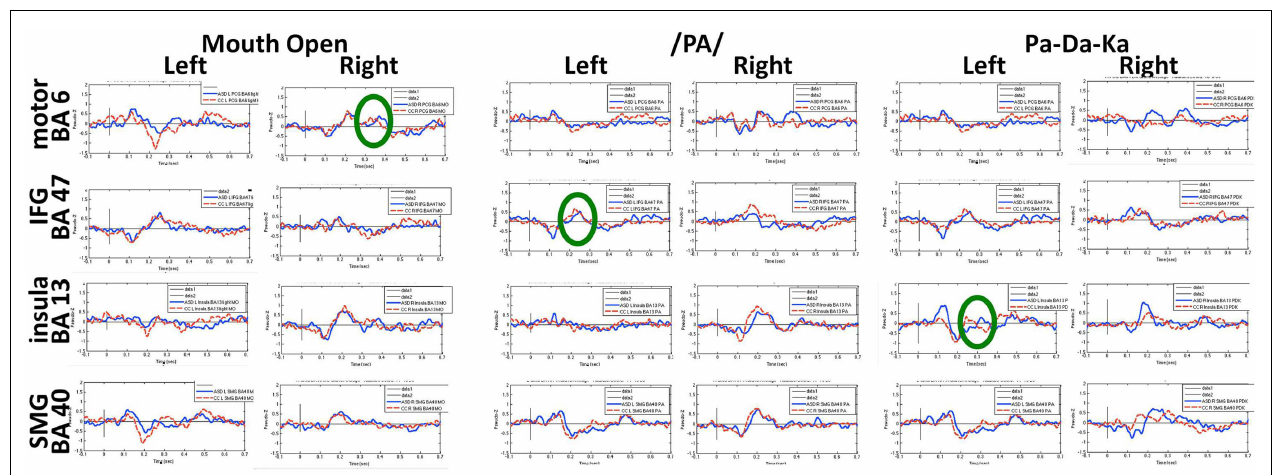
FIGURE 6 |Time courses of activations used in magnitude analyses for each speech production condition. Circles indicate neural locations where statistically significant differences were seen in the peak magnitude between children with autism (blue line) and control children (red line).These data for Figures 6 and 7 were analyzed with synthetic aperture magnetometry beamforming (Robinson andVrba, 1999;Vrba